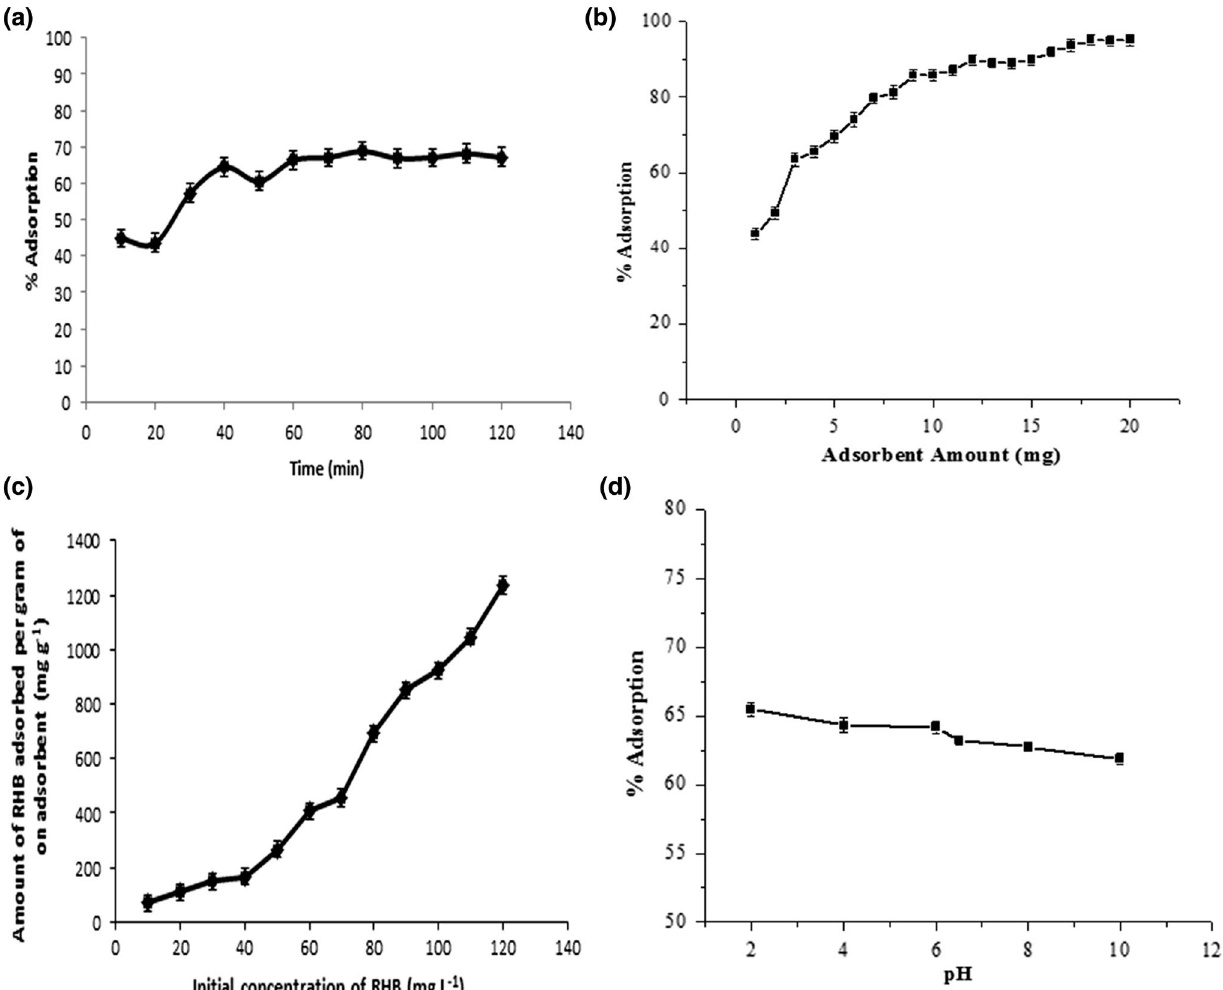
Fig. 1 Influence of various parameters on RHB adsorption. a Contact time, b adsorbent dose, c initial concentration, d solution